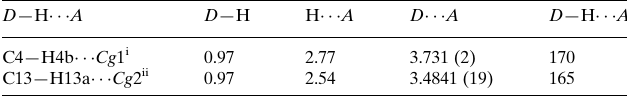
Hydrogen-bond geometry (A˚ , (cid:2)